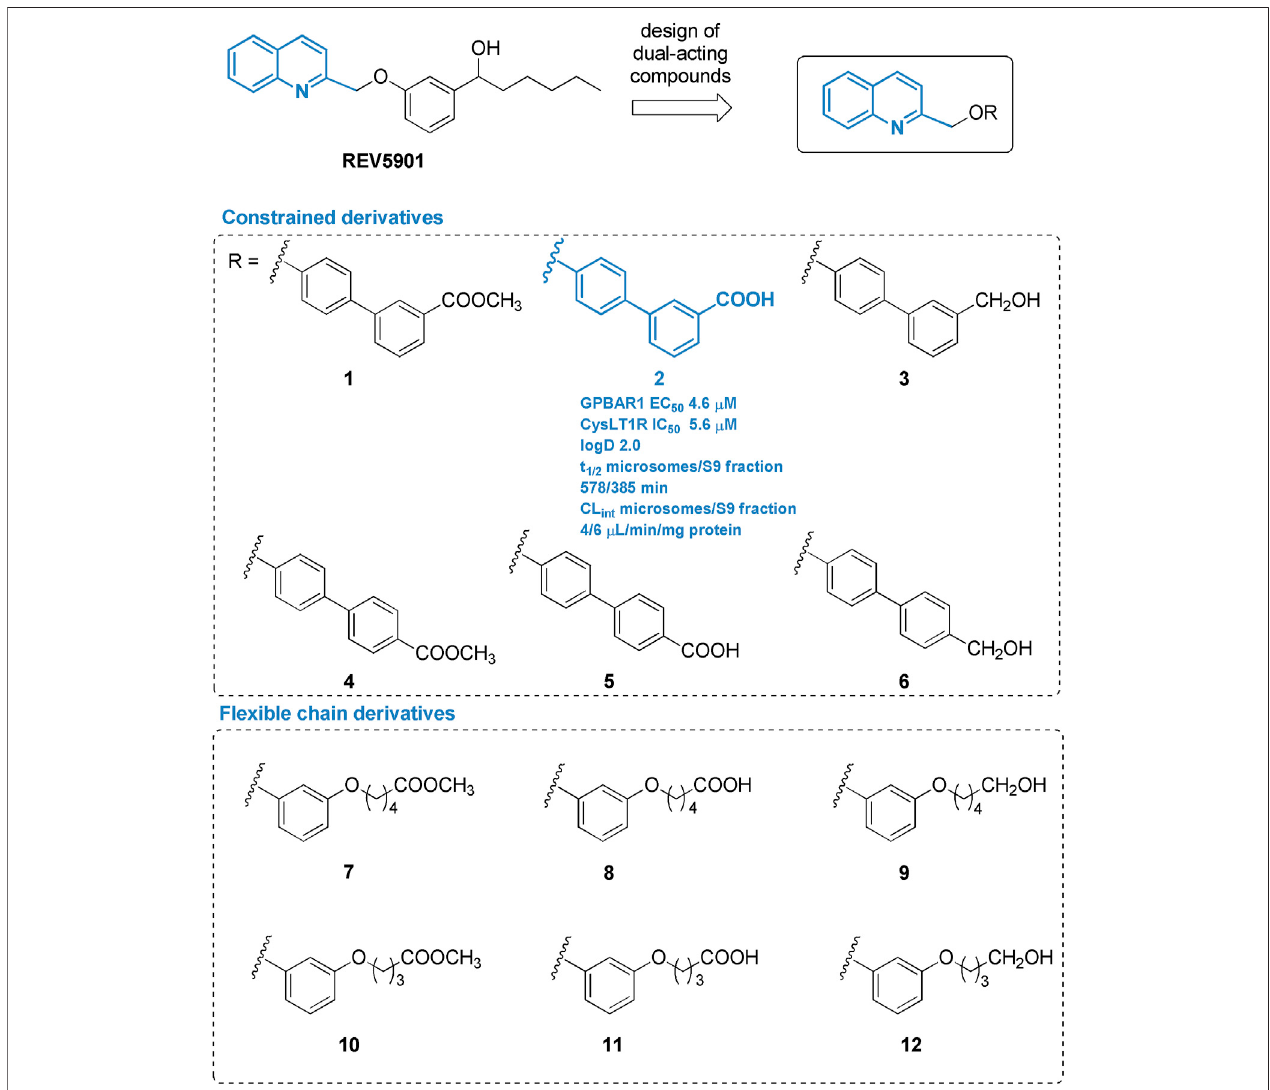
FIGURE 1 | Chemical structure of derivatives identi fi ed in this